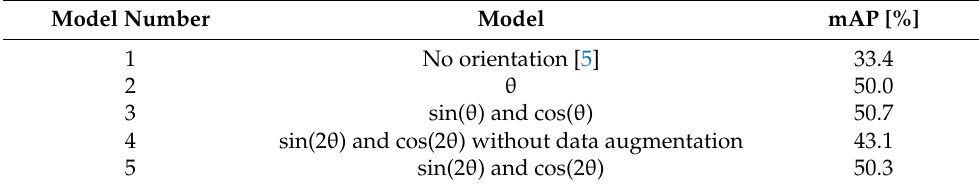
Table 3. Map score for each experiment.